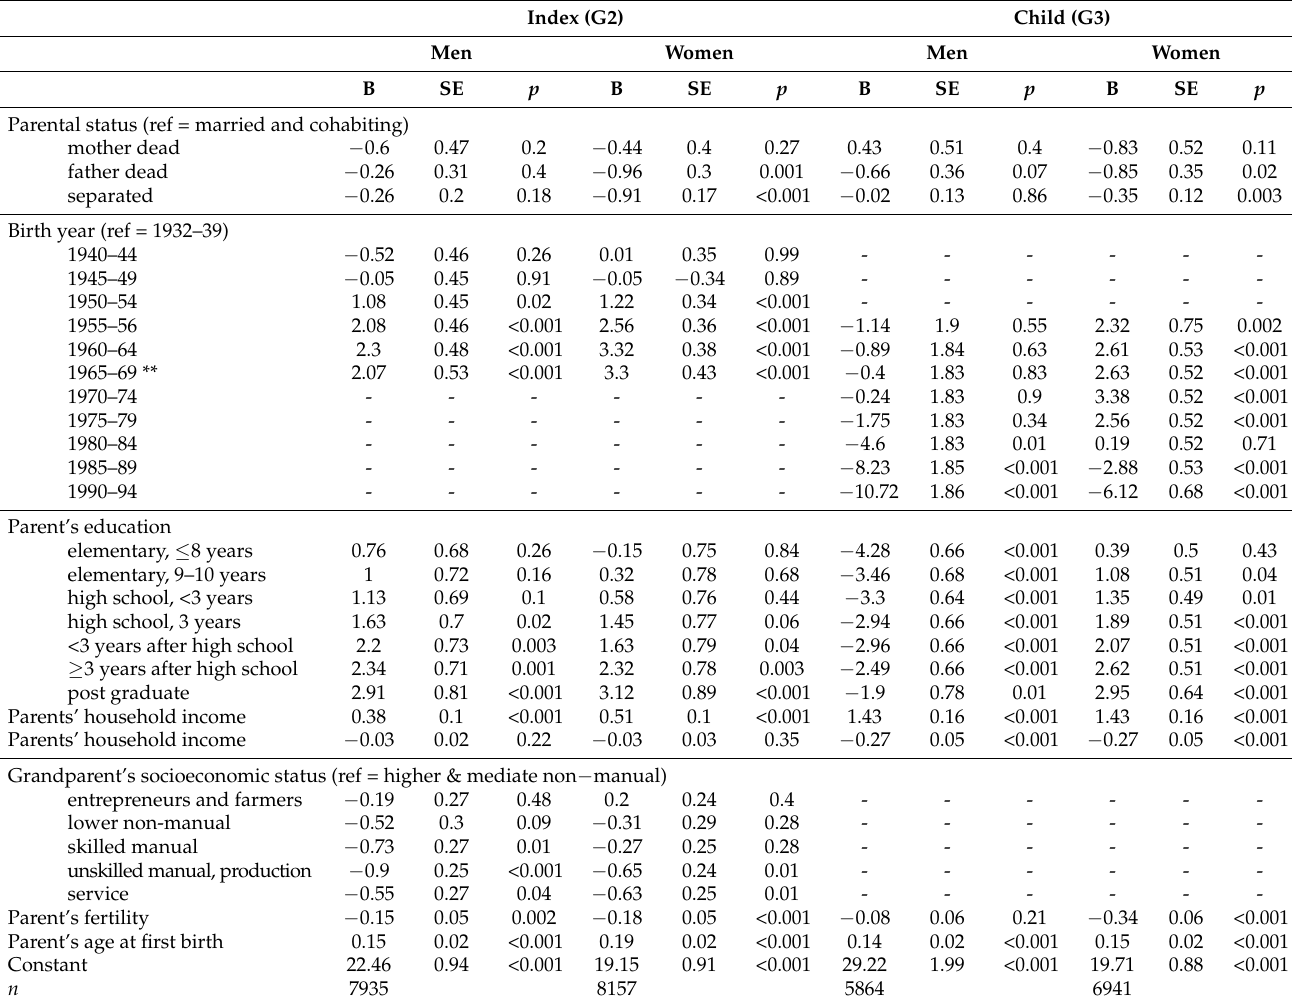
Table 2. Linear regression models predicting age at first birth from parental presence within first 20 years of life. Robust standard errors controlling for family clusters (parent’s id) are